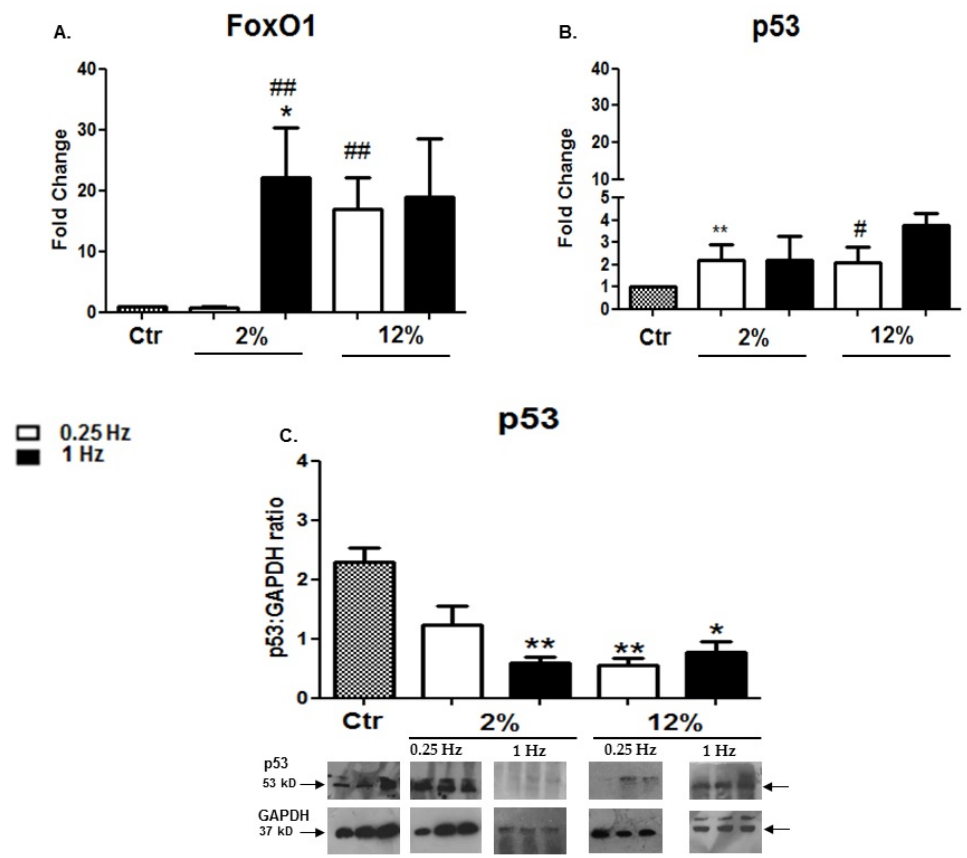
Figure 5. ( A , B ) Effects of mechanical loading on the expression of pro-apoptotic factors. Quantitative analysis of ( A ) FoxO1 and ( B ) p53 mRNA expression in differentiated cardiomyocytes subjected to various mechanical stretching protocols compared to the control (Ctr; nonstretched myotubes); the transcriptional responses of pro-apoptotic factors in stretched myotubes have been normalized to the corresponding GAPDH mRNA values and are expressed as fold changes compared to the control. ( C ) Representative Western blots and immunoblotting quantification of p53 subjected to the different stretching protocols compared to the control (nonstretched myotubes). The p53 protein levels were normalized to each corresponding GAPDH on the same immunoblot. The same blots have been used for GAPDH in Figutes 3D,E, 5C, and 7A,B except from the blot of GAPDH in panel A for the 2%/1 Hz stretching protocol, Significantly different compared to the control, * p < 0.05; ** p < 0.01. Significantly different compared to the 2%/0.25 Hz stretching protocol, # p < 0.05; ## p < 0.01. Mean + SE of three independent experiments performed in